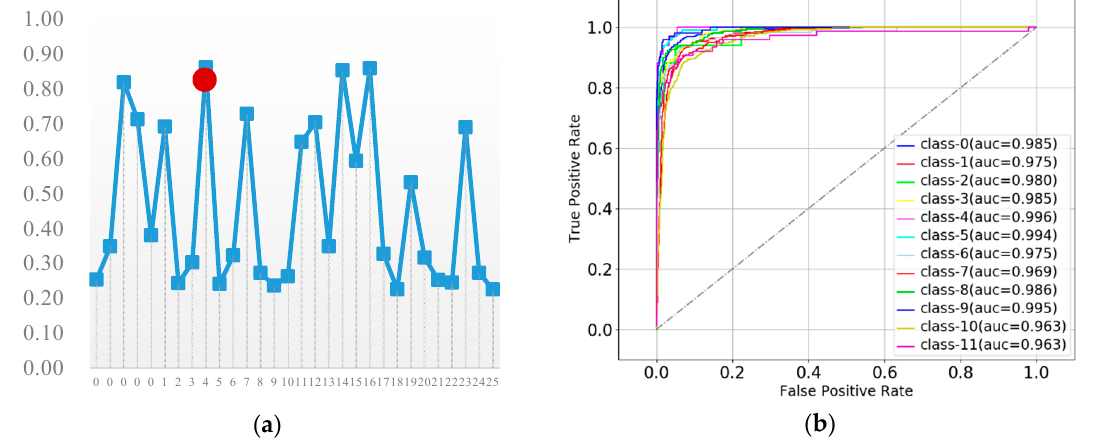
Figure 13. Parameter Tuning Process and ROC of Gradient Boosting Decision Tree (GBDT), where ( a ) Description of the parameter tuning process of GBDT, where y -axis is ACC and x -axis is iteration; ( b ) ROC of GBDT. Table 13. Parameter Tuning Process of GBDT Classifier.